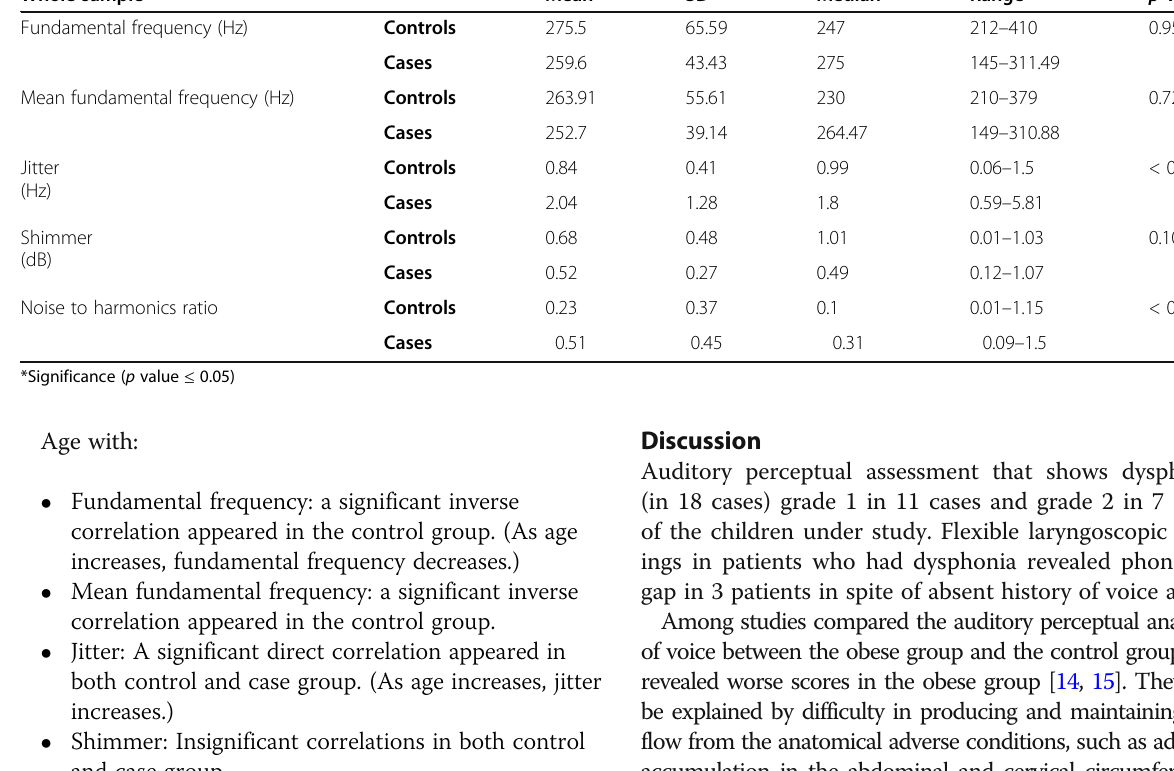
Table 4 Comparison of the numerical predictors between cases ( N = 30) and controls ( N = 30) Whole sample